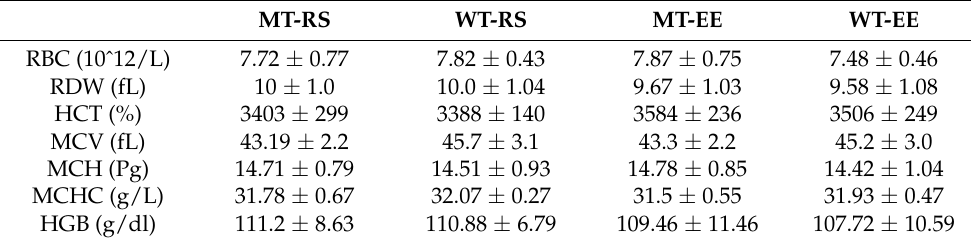
RBC: red blood cell count; RDW: red cell distribution width; HCT: hematocrit; MCV: mean corpuscular volume; MCH: mean corpuscular hemoglobin; MCHC: mean corpuscular hemoglobin concentration; HGB: